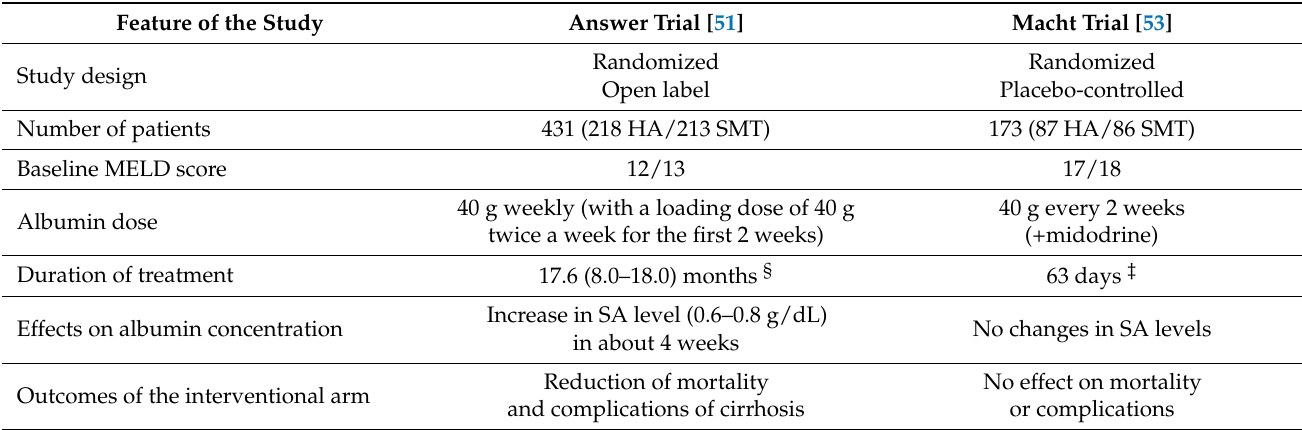
Table 3. Comparison of the two available RCTs on long-term albumin use for decompensated cirrhosis and ascites [52,54]. Feature of the